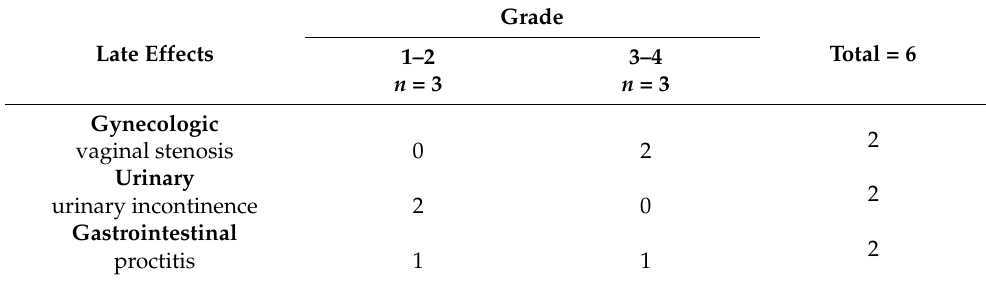
Table 3. Late toxicities according to CTCAE